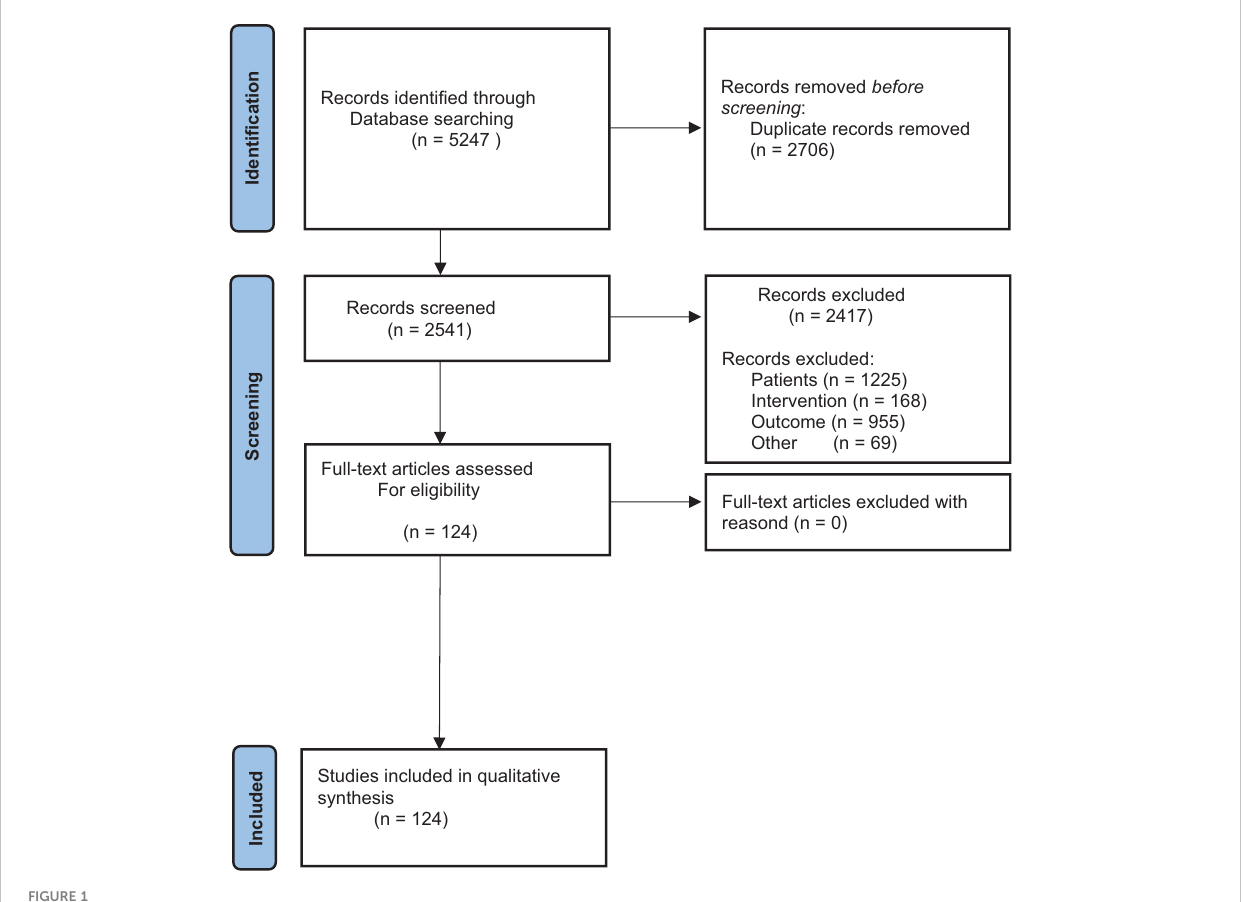
FIGURE 1 The fi gure shows the Prism Flow Diagram. It shows the systematic process of literature